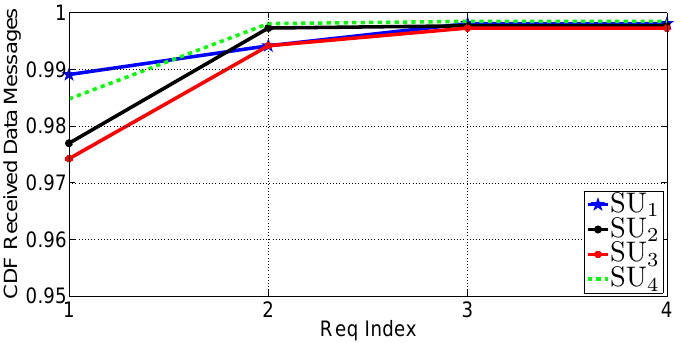
Figure 26. CDF of the received DATA messages before a REQUEST in Scenario